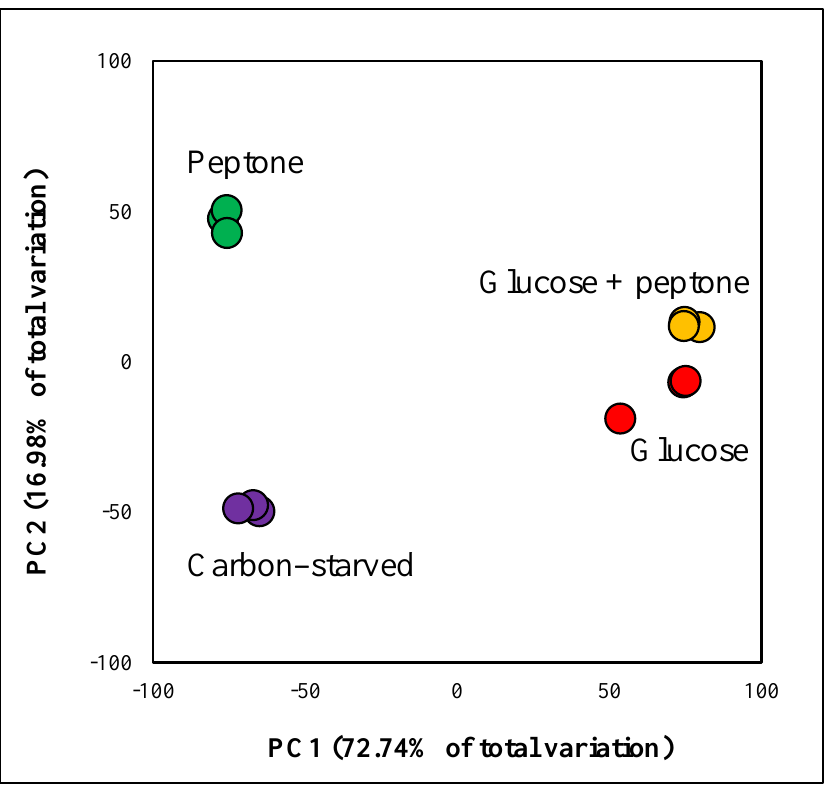
Figure 4. Principal component (PC) analysis of the transcriptome data. The analysis was carried out using the rlog data generated by DESeq2 software.